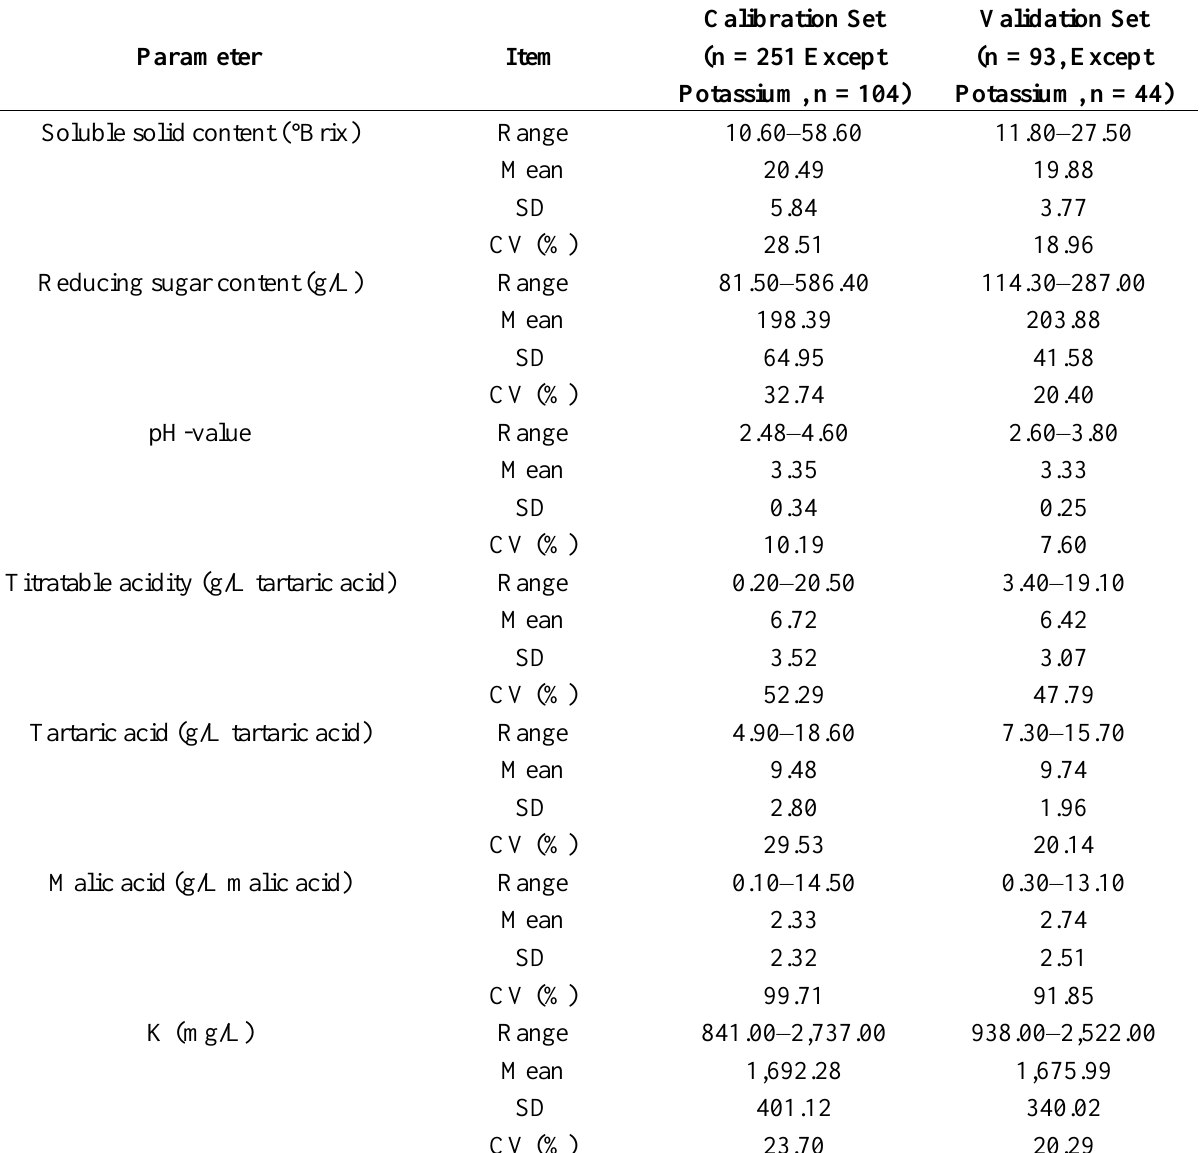
Table 1. Statistical analysis of calibration and validation sets: data range, mean and standard deviation (SD) and coefficient of variation